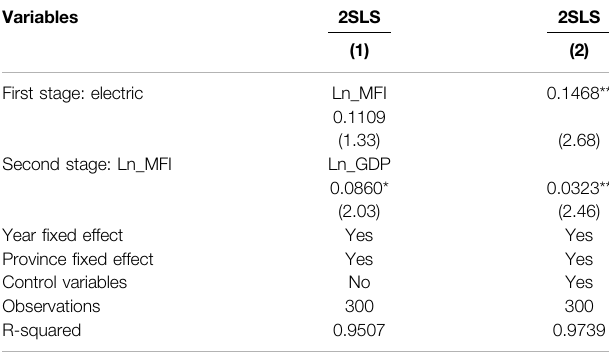
TABLE 8 | Impacts through increasing investment in fi xed assets of